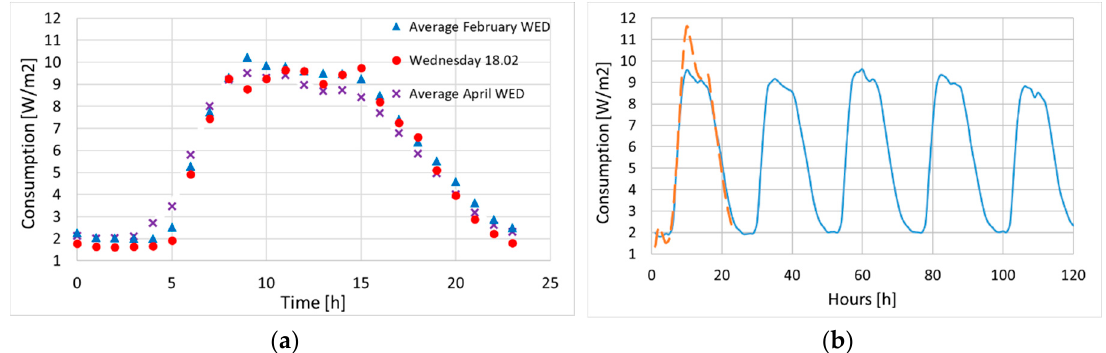
Figure 9. ( a ) Wednesday 18.02.15 vs. average February and April Wednesdays; ( b ) structural curve (dashed) vs. yearly average (solid) for each weekday, Mon to Fri.